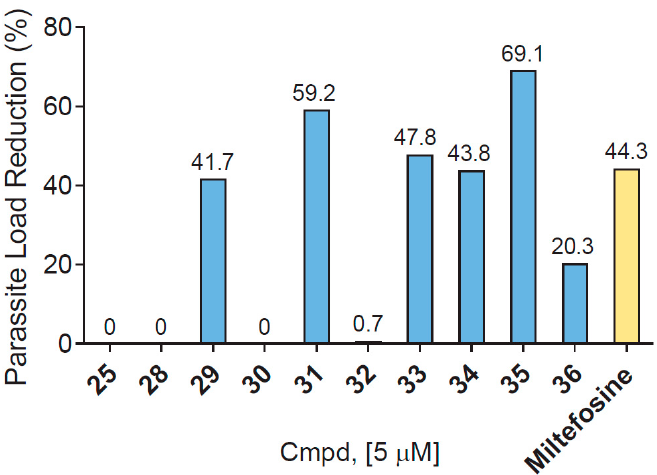
Figure 2. In vitro evaluation of activity against L. donovani infected bone marrow-derived macrophages.